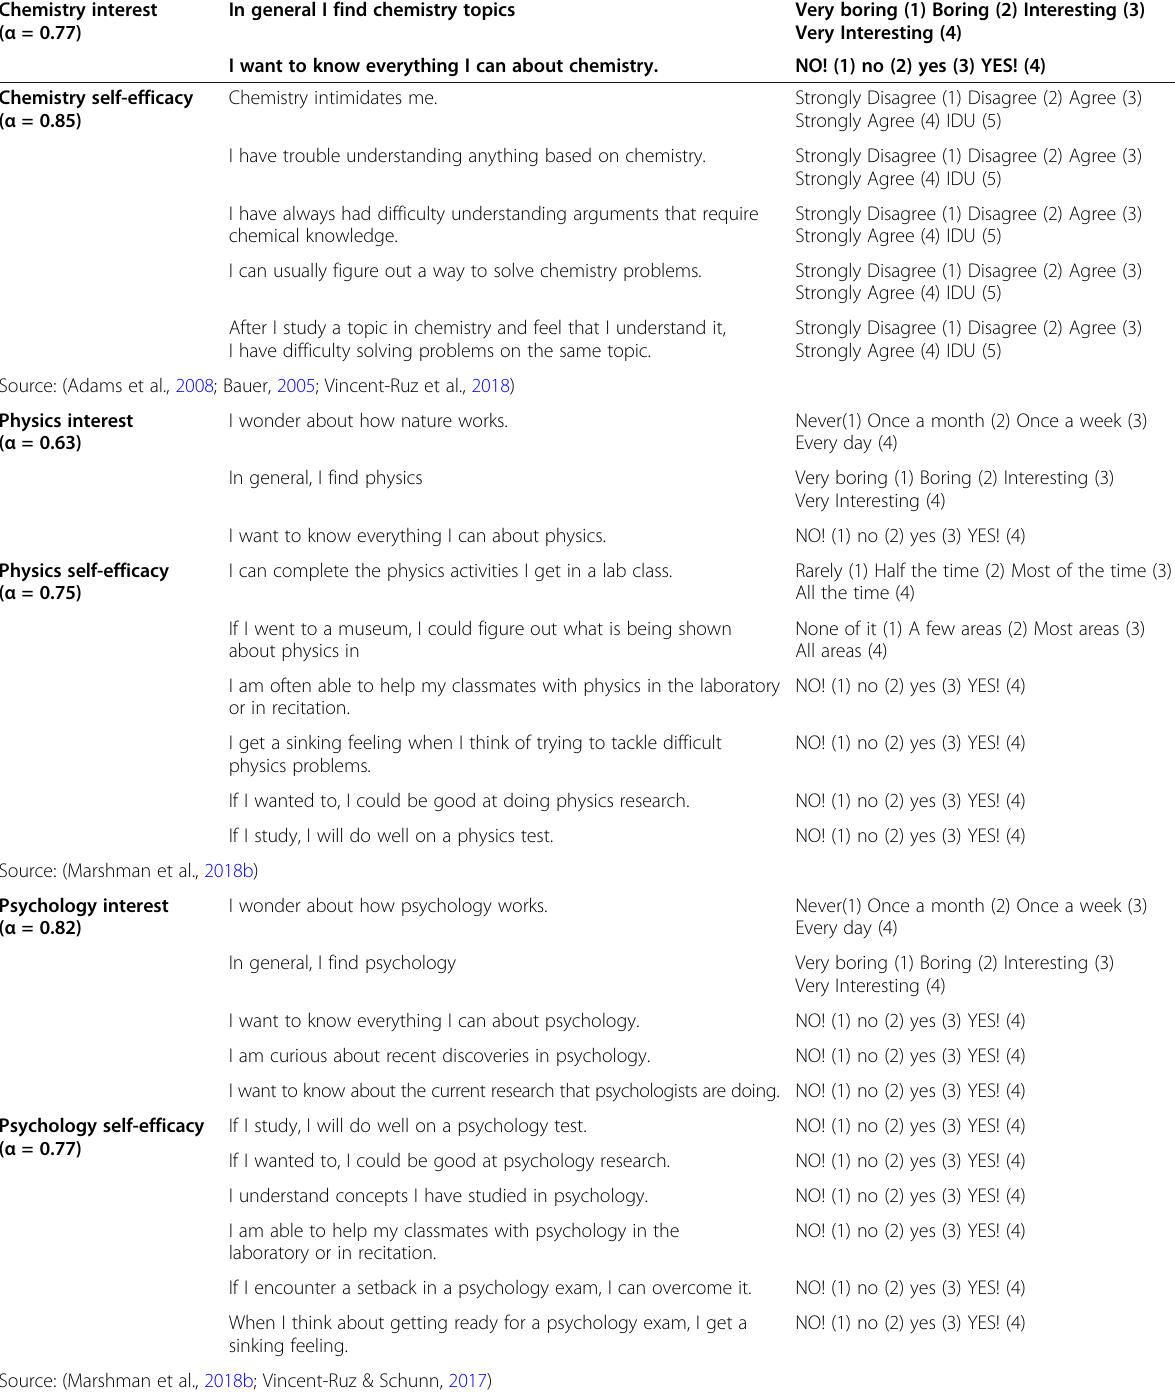
Table 2 Survey questions used for discipline-specific interest and self-efficacy variables Chemistry interest ( α =